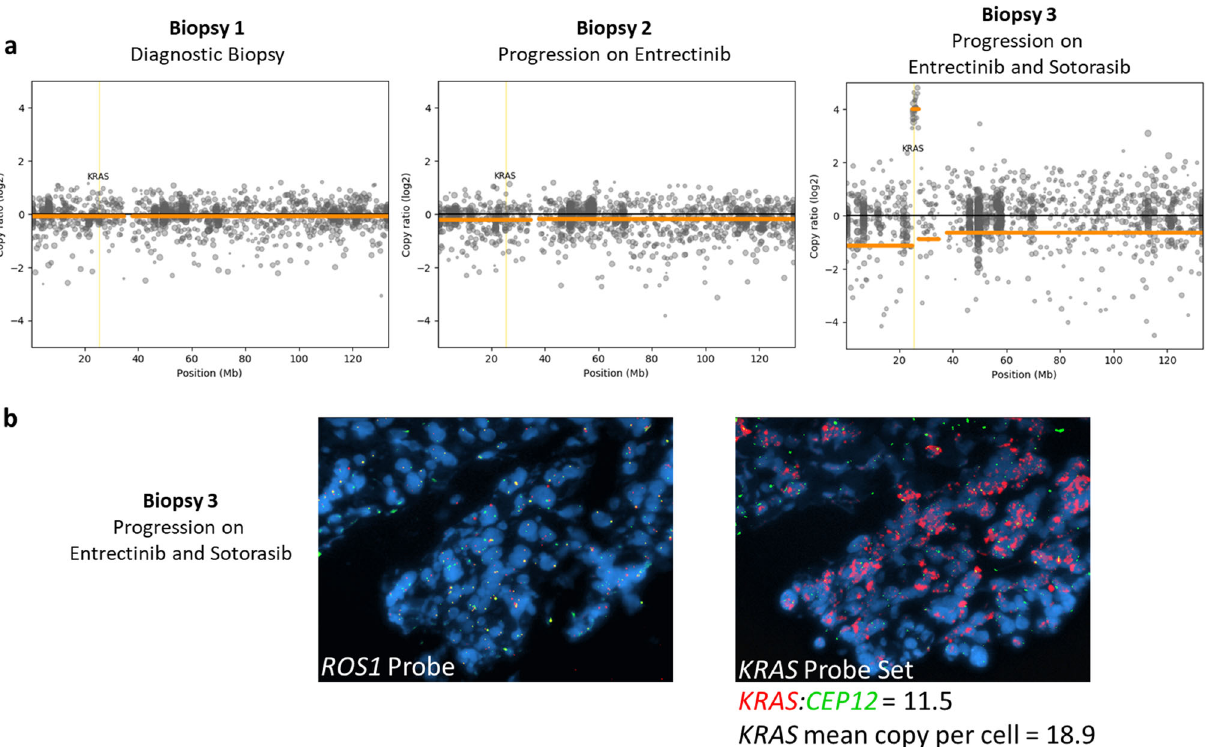
Fig. 3 Identi fi cation of KRAS ampli fi cation at time of patient progression on entrectinib and sotorasib. a KRAS copy number alterations identi fi ed on sequencing of clinical biopsies at time of diagnosis (left), progression on entrectinib (middle), and progression on entrectinib and sotorasib (right). b ROS1 and KRAS FISH on patient biopsy after progression on entrectinib and